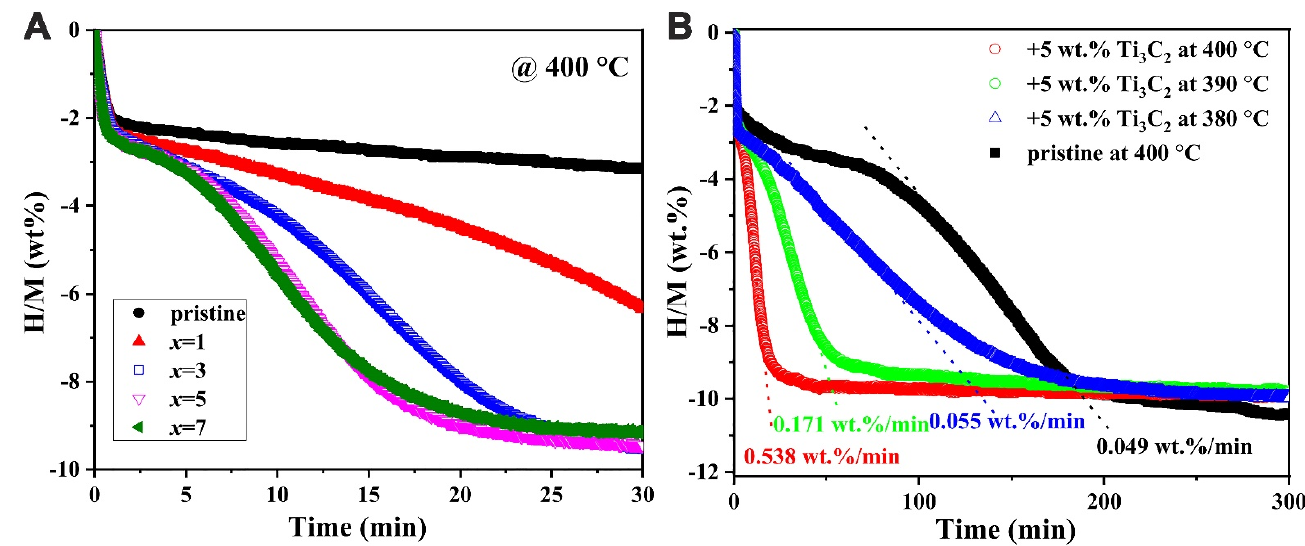
Figure 7. ( A ) Isothermal dehydrogenation curves (400 ◦ C, 0.4 MPa H 2 ) of initially hydrogenated 2LiH and MgB 2 and x wt% Ti 3 C 2 systems; ( B ) Isothermal dehydrogenation curves at different temperatures of the systems with 5 wt% Ti 3 C 2 addition and without Ti 3 C 2 . Figure is reprinted with permission from ref. [184].